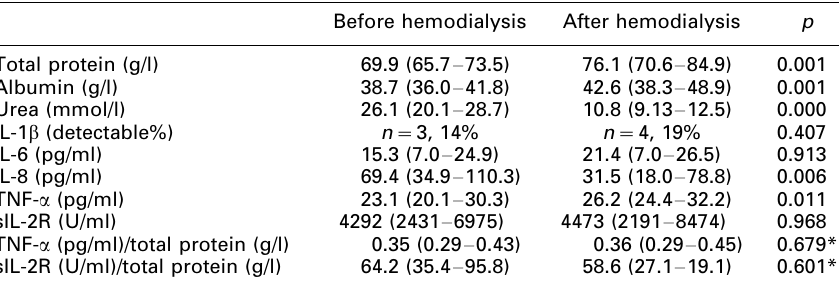
Table 1. Circulating cytokine levels in pre-hemodialysis and post-hemodialysis specimens Before hemodialysis After hemodialysis p Total protein (g/l)